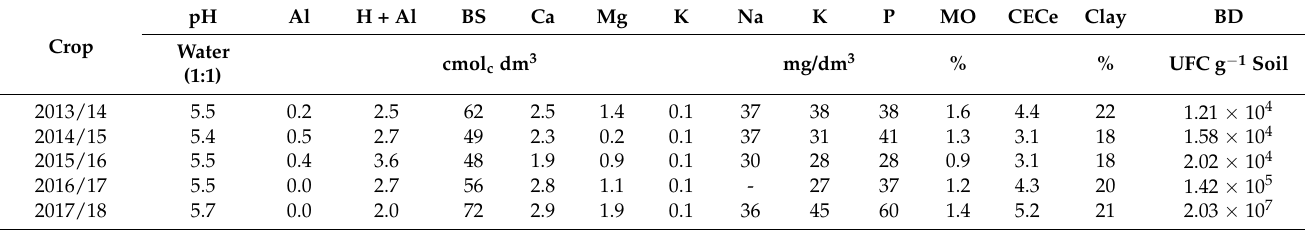
Table 3. Chemical and physical attributes (0–20 cm) and population of diazotrophic bacteria (0–10 cm) in the soil of the experimental